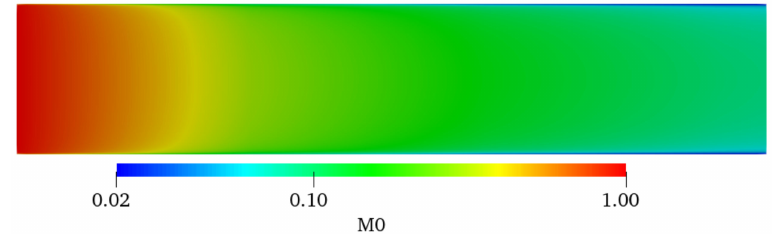
Figure 6. Distribution of M 0 in the region of 0 ≤ x ≤ 5 D (Re = 8819, ϕ =